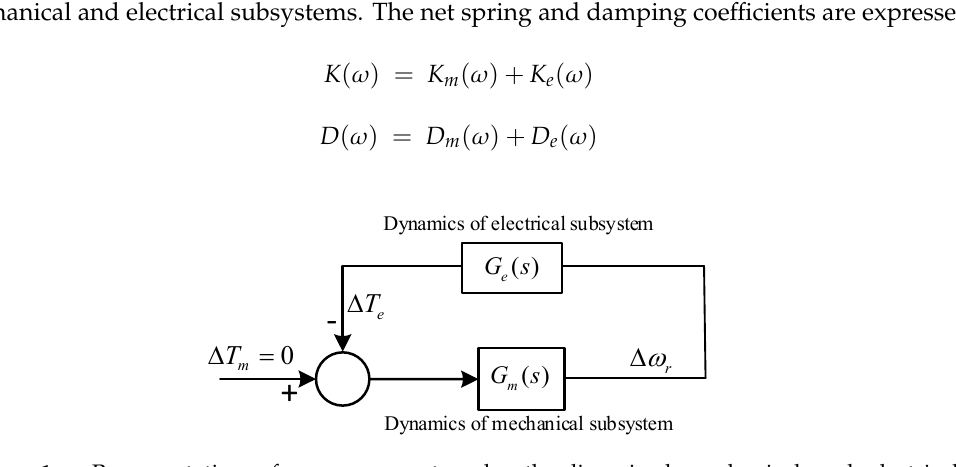
Figure 1. Representation of a power system by the linearized mechanical and electrical dynamic subsystems.